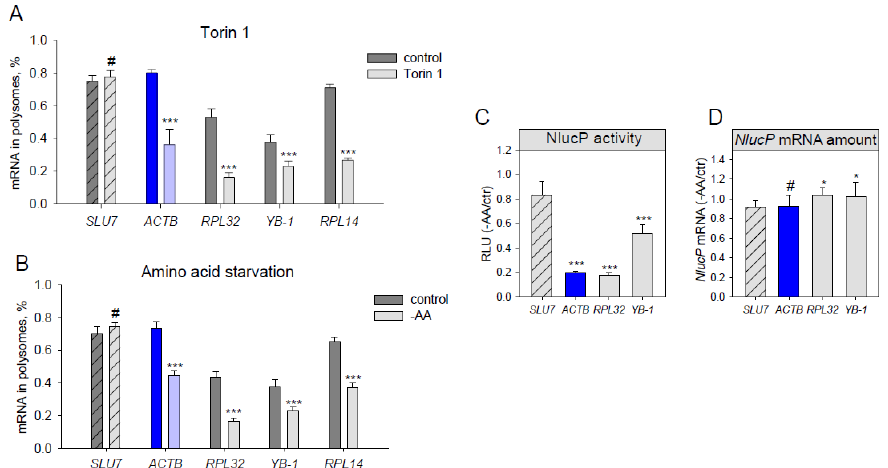
Figure 2. Translation of endogenous β -actin mRNA decreases under amino acid starvation and mTOR inhibition. ( A – B ) HEK293T cells were treated for 2h with DMSO (control), 500 nM Torin1 ( A ), or subjected to amino acid and serum starvation ( B ). The cells were lysed, fractionated at a sucrose gradient of 15 – 45%, and mRNA abundance of endogenous SLU7 , ACTB , RPL32 , RPL14 and YB-1 in polysome- and subpolysome fractions was measured by qPCR. A polysome fraction was estimated as (mRNA in polysome)/(mRNA in polysome + mRNA in subpolysome). ( C – D ) HEK293T cells were transfected with pNL2.2 ; after 2h of amino acid and serum starvation (-AA) the cells were collected, and luciferase activity ( C ) and NlucP mRNA abundance ( D ) were measured. Student’s t -test was used to estimate the statistical significance versus control treatment ( A – B ) or versus the SLU7 control ( C – D ), *** p < 0.001; * p < 0.05; # — nonsignificant.